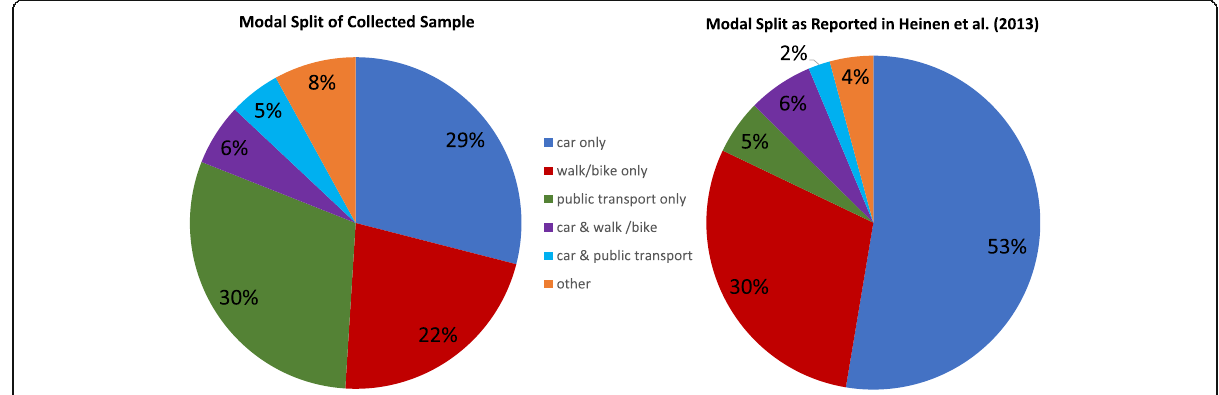
Fig. 2 Commuting modal split of the collected sample (left) and the Dutch average